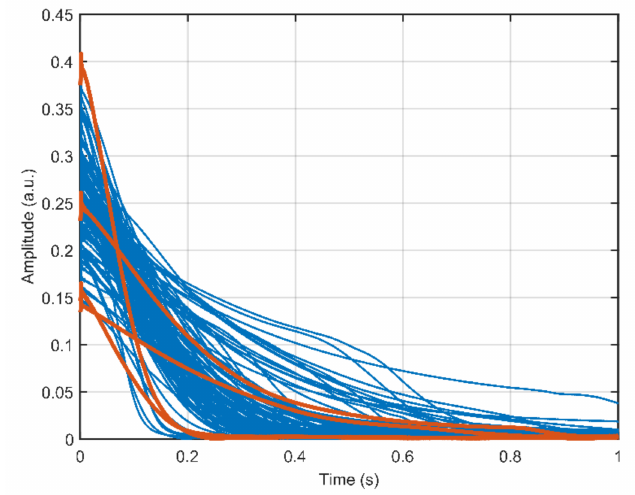
Figure 3. CPMG signal amplitude as a function of time shown for a set of measurements performed on a slug flow-like water-air multiphase flow. The two pairs of CPMG signals printed in red show that different signal amplitudes at t = 0 s can occur for the same signal amplitude decay